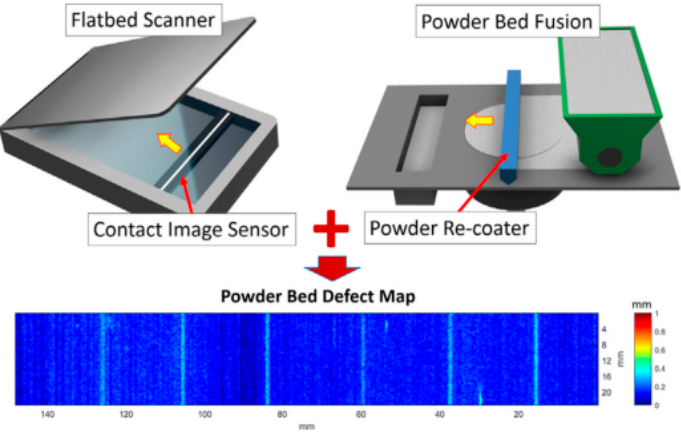
Figure 4. Components of powder scanner